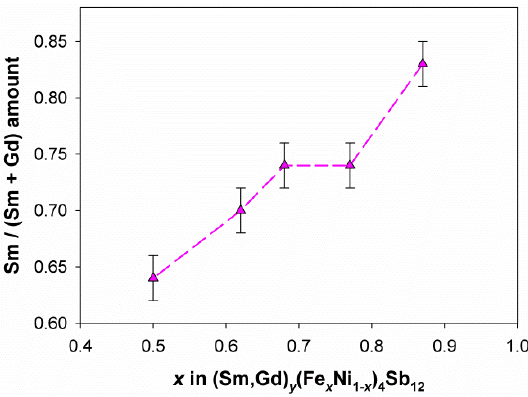
Figure 5. The trend of the refined Sm/(Sm + Gd) amount ratio as a function of the Fe content.